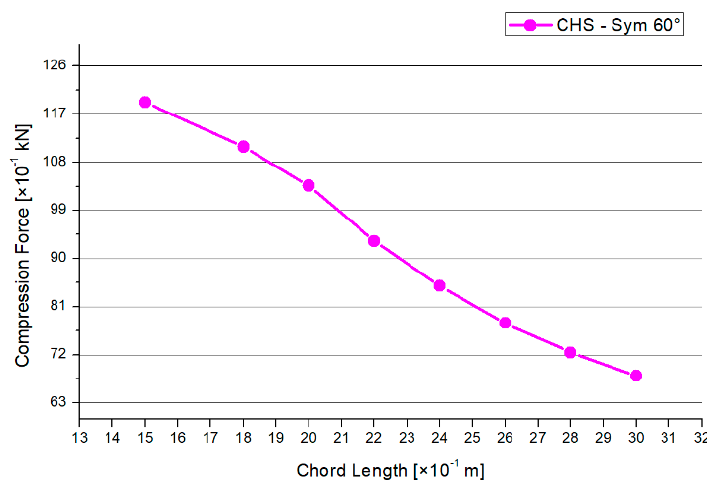
Figure 14. Results—Maximum Compression Force.